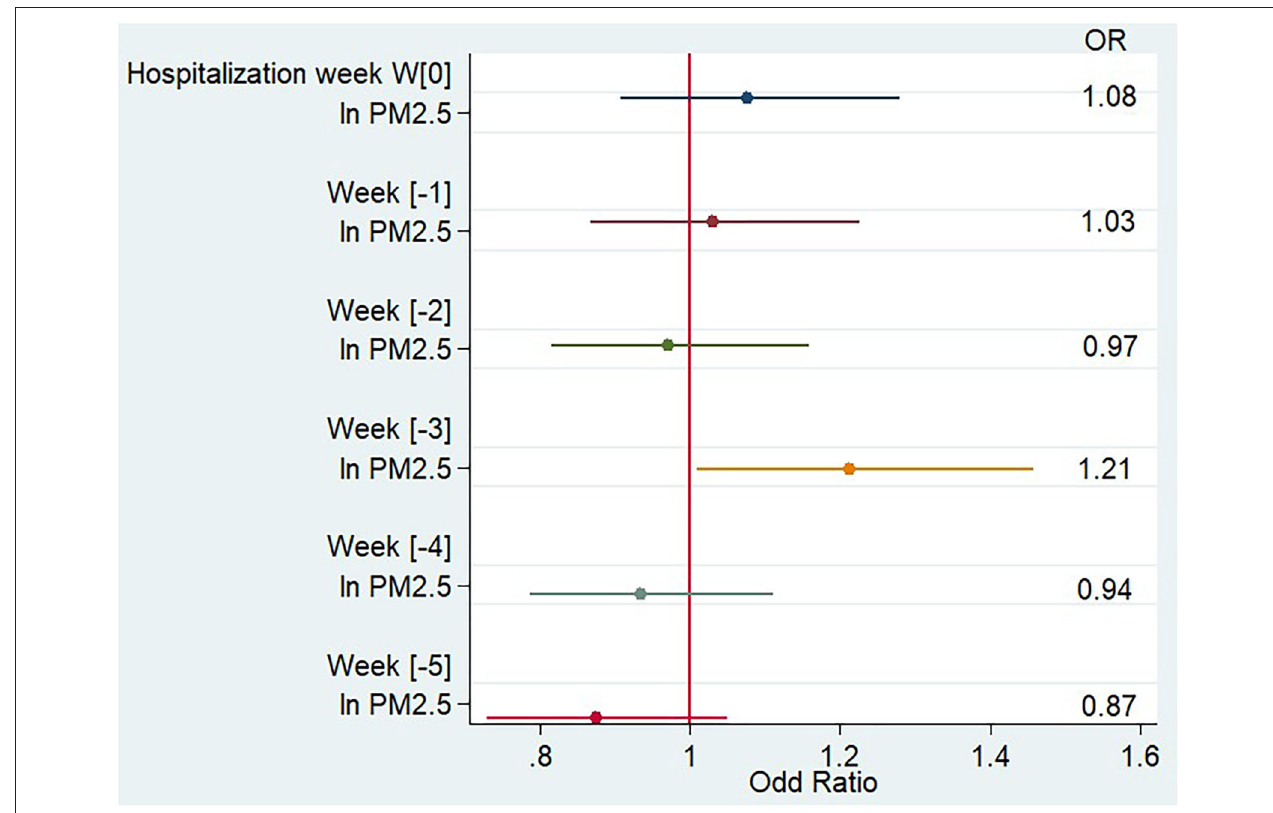
FIGURE 2 | Impact of PM 2.5 weekly concentration on the risk of multiple sclerosis relapse, multivariate